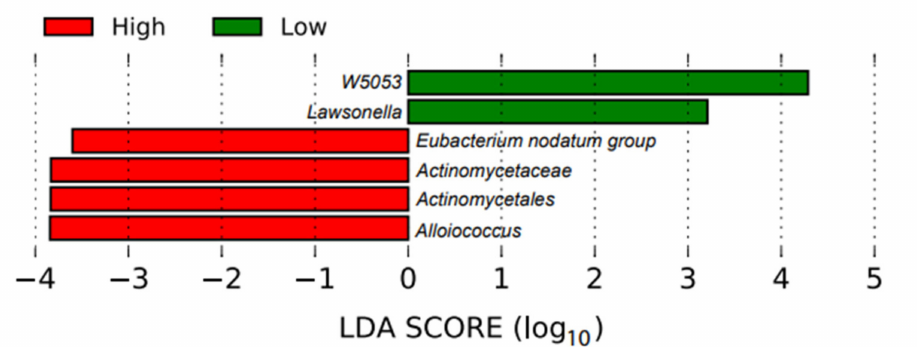
Figure 3. Linear discriminant analysis effect size plot. This plot shows the enriched taxa that were significantly different between the high fertility (red) and low fertility (green)